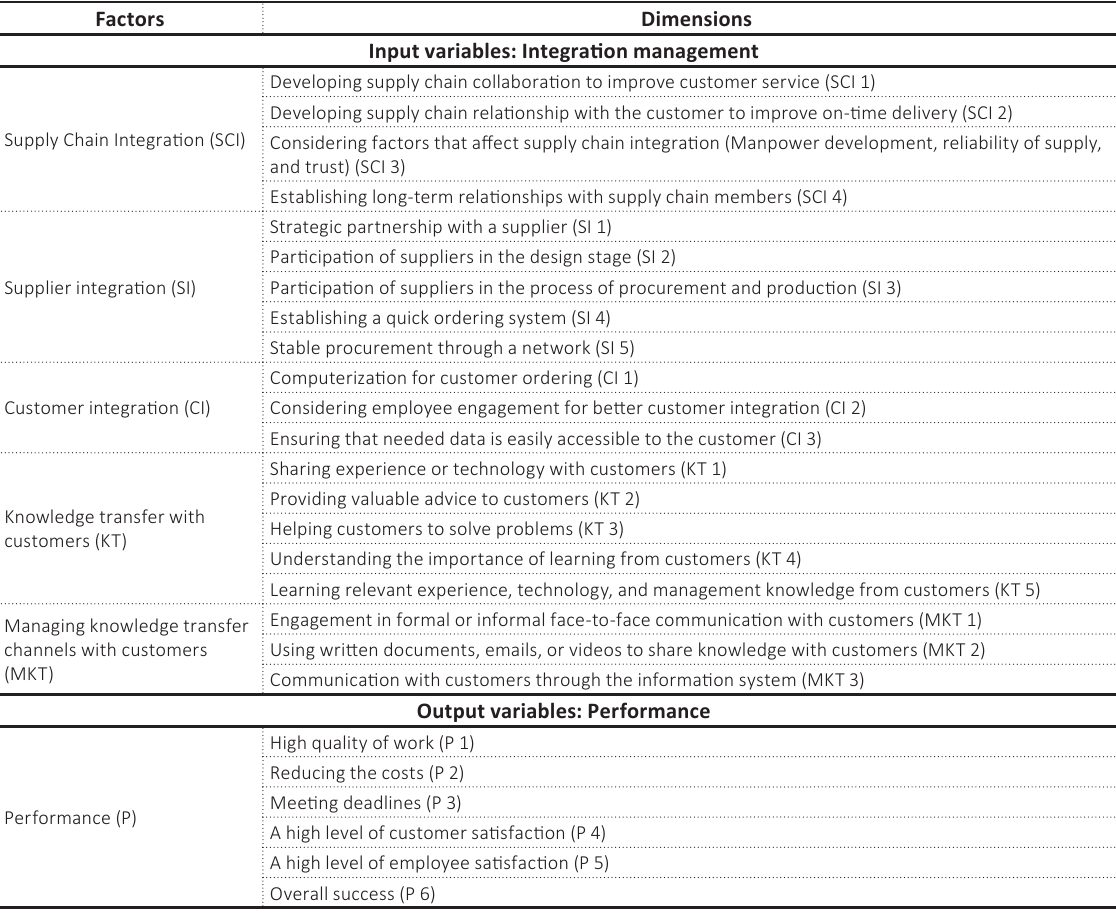
Table 1. Factors and dimensions of integration management and performance Factors